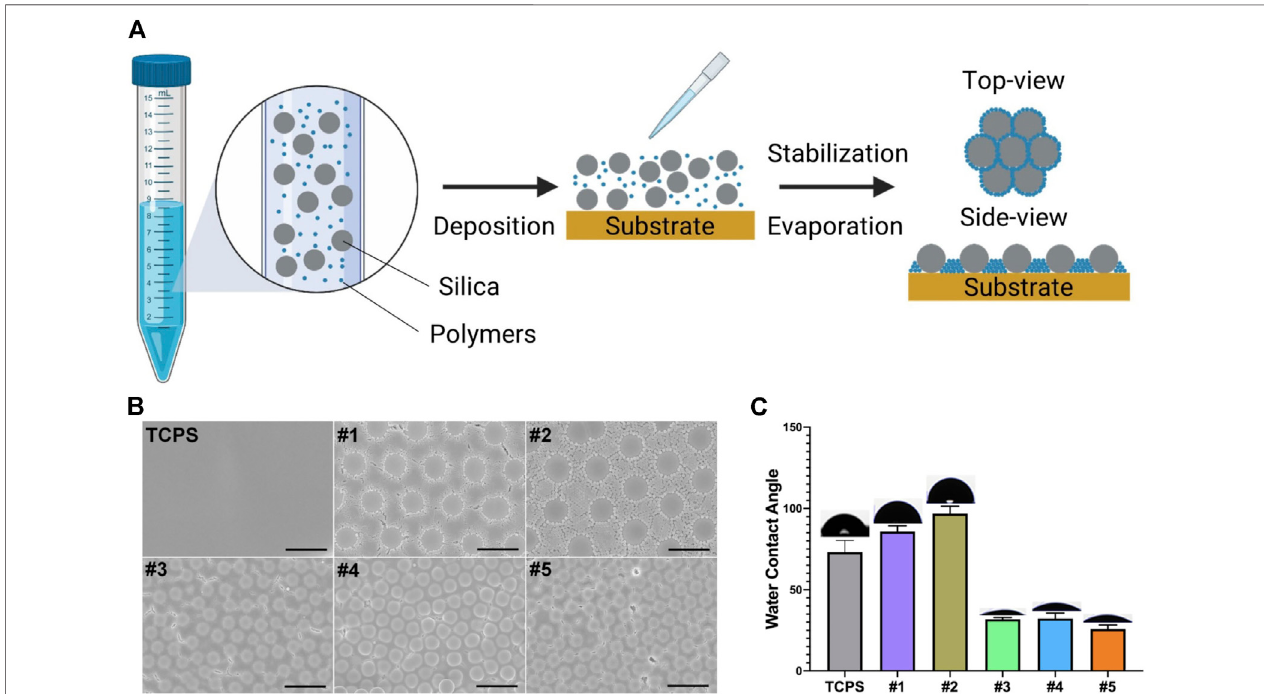
FIGURE1| FabricationandcharacterizationofcSAPSs. (A) SchemeofcSAPspreparation. (B) SEMofTCPSand fi veselectedcSAPs.Scalebarrepresents5 μ m. (C) Surface wettability of the substrates was analyzed using water contact angle test (degrees). Five spots on each surface were analyzed ( n (cid:1) 5). Error bar (cid:1) STDEV.